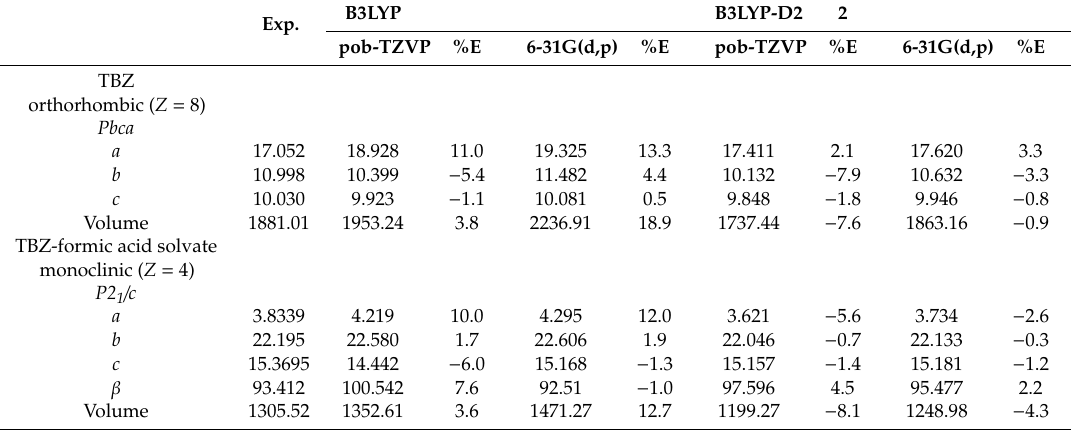
Table 4. Comparison between experimental, B3LYP and B3LYP-D2 computed cell parameters for TBZ and TBZ-formic acid solvate crystals a